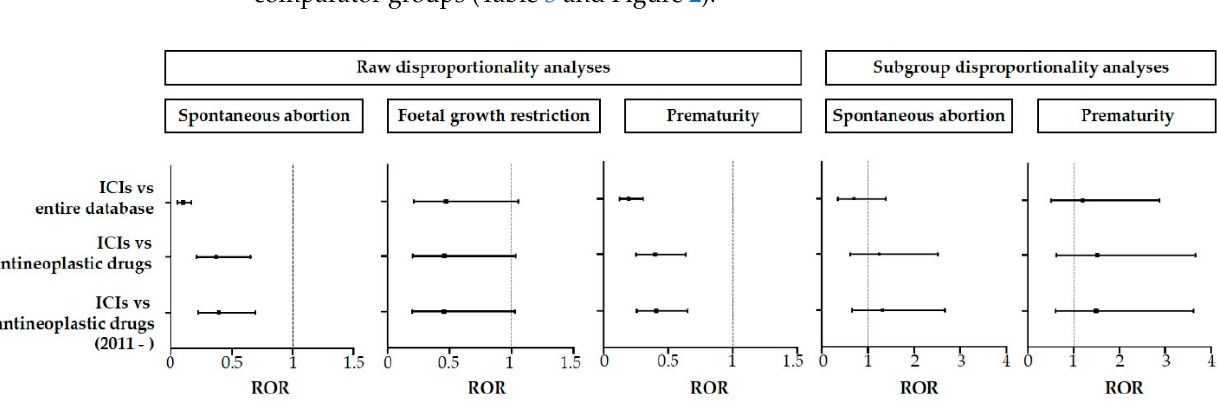
Table 3. Computation of reporting odds ratios and 95% confidence intervals in raw and subgroup (by sex and age, females aged 20–44 years) dis- proportionality analyses.